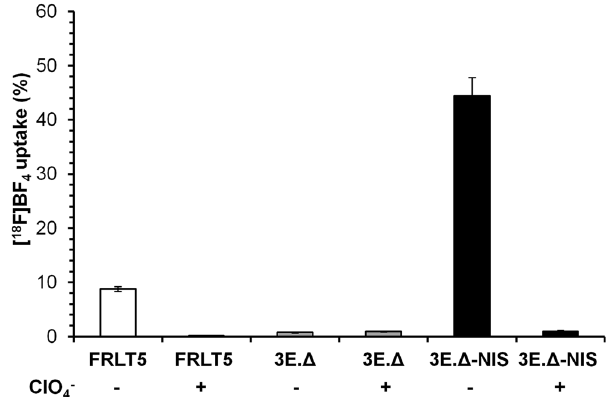
Figure 1. The exogenously expressed NIS reporter is functional in highly invasive breast carcinoma cells. [ 18 F] BF 4 − uptake was measured in vitro in highly metastatic cell lines either stably expressing the reporter gene NIS- TagRFP (3E. Δ -NIS, black bars) or not (3E. Δ ). Uptake was compared to that of FRLT-5 thyroid cells, which endogenously express NIS if grown in the presence of TSH (see Materials and Methods). Perchlorate blockade was used to demonstrate uptake specificity. Error bars represent SD of three independent experiments, each in